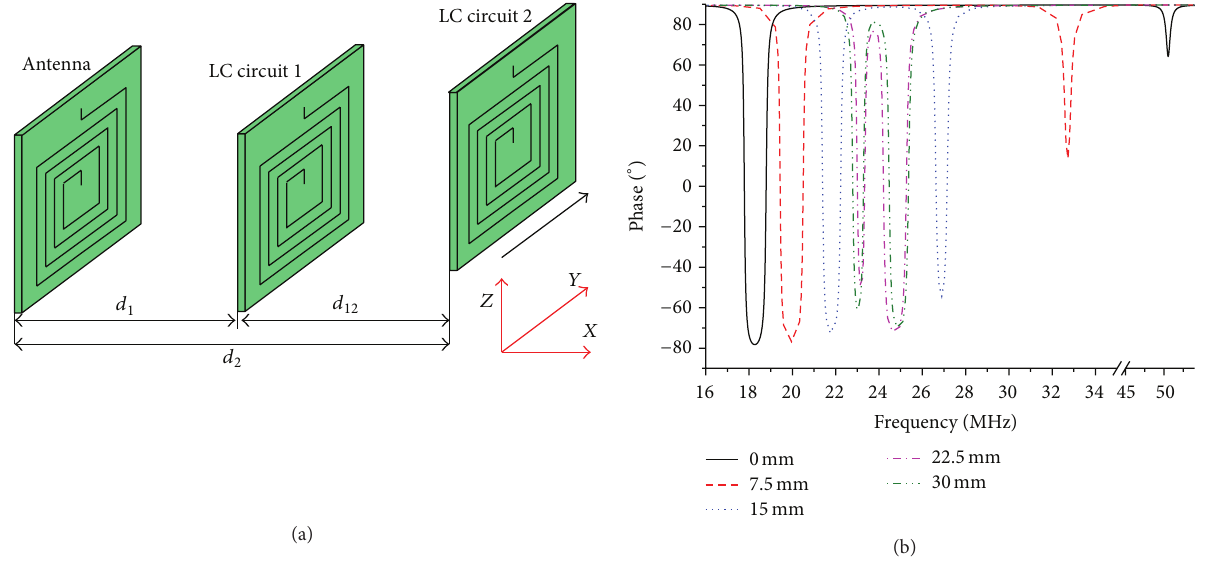
Figure 13: (a) Relative position of the three coils. (b) Test